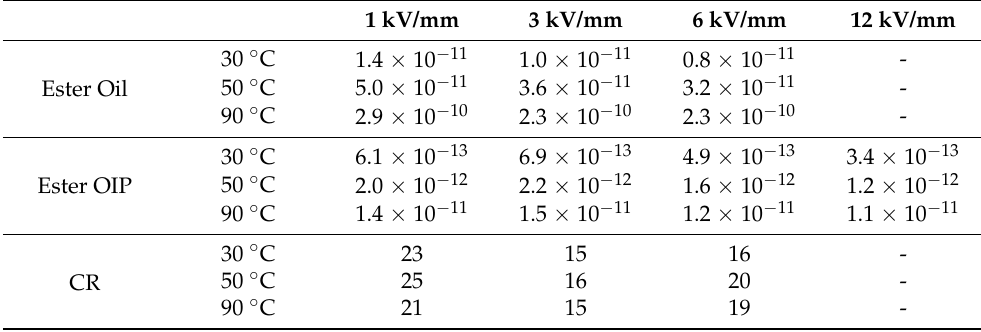
Table 2. Conductivity measurement results for ester oil/OIP and their conductivities ratio (CR). 1